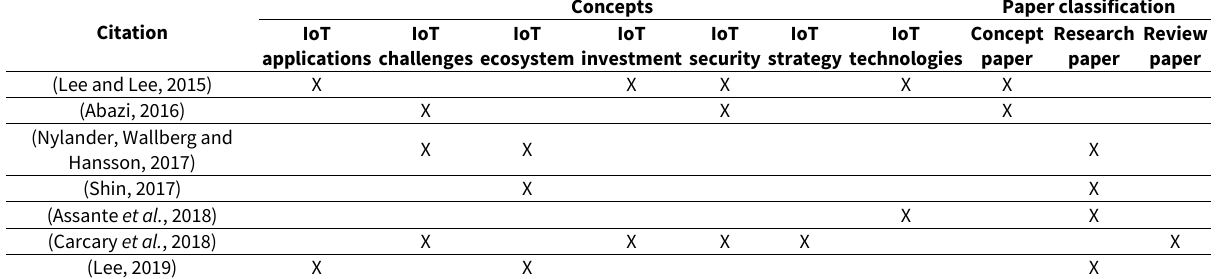
Table 1. The IoT adoption concept matrix and paper classification Citation